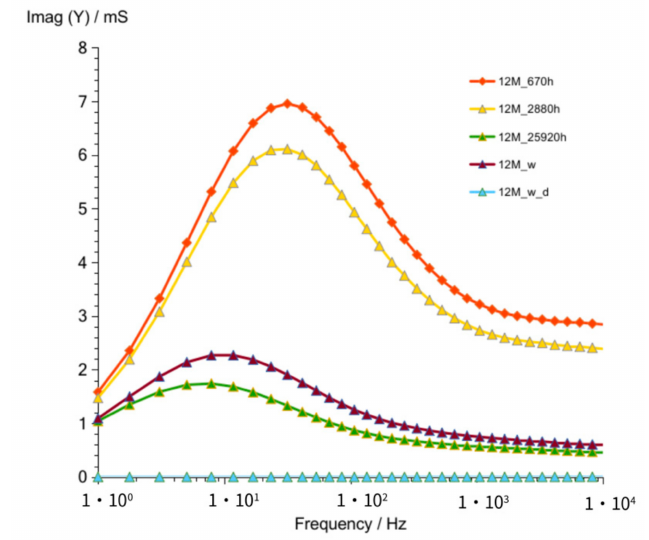
Figure 15. Susceptance of G12M geopolymer concrete taken after 670 to 25,920 h from starting